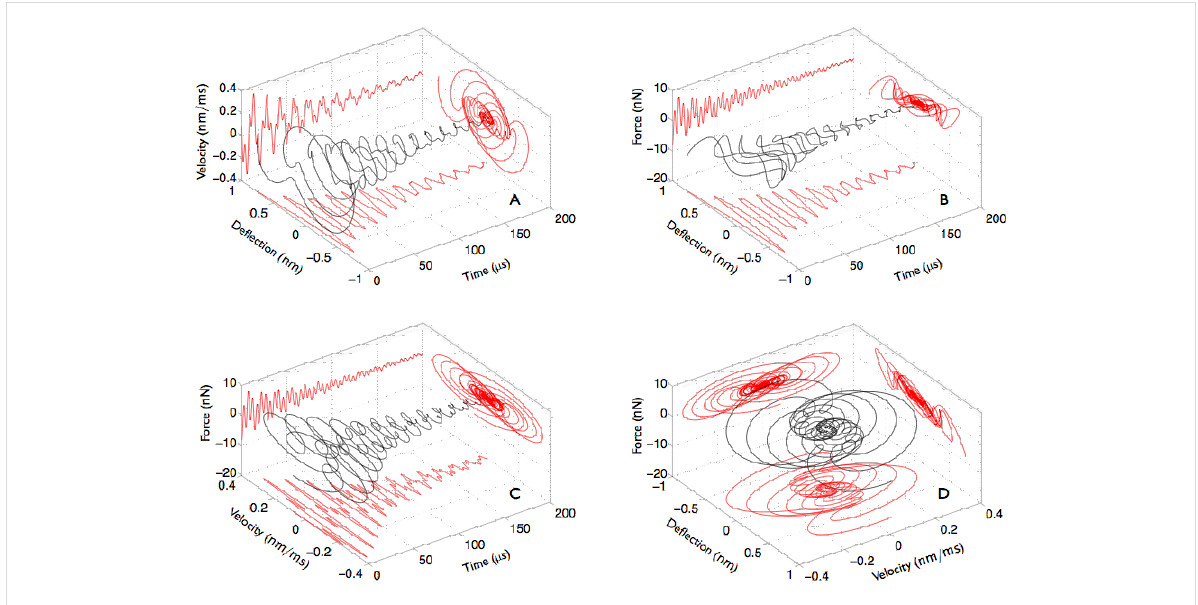
Figure 3: 3D-representation of the main observables describing the tip dynamics during the jump-to-contact transition. (A) deflection–velocity , (B) deflection–force and (C) velocity–force phase-spaces evolving in time. (D) Force vs velocity vs displacement phase-space representation.